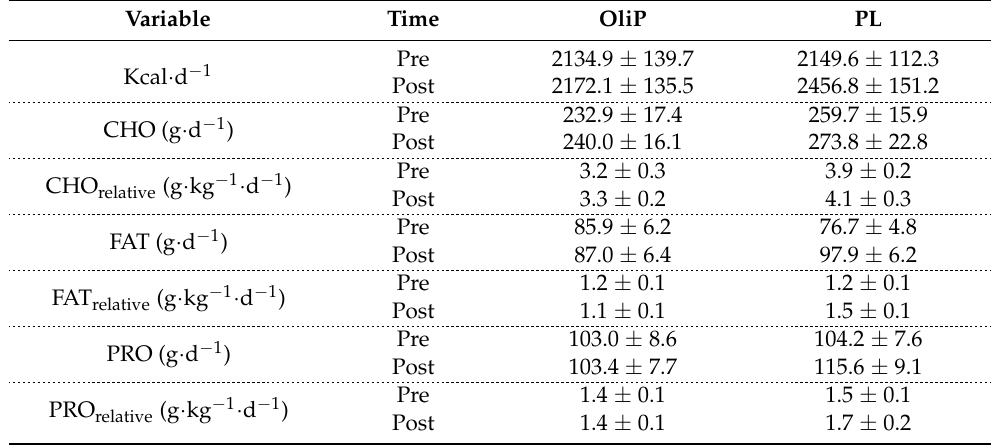
Table 2. Energy and macronutrient intake for both groups within the 3-day control period prior to visit 2 (pre-intervention) and 4